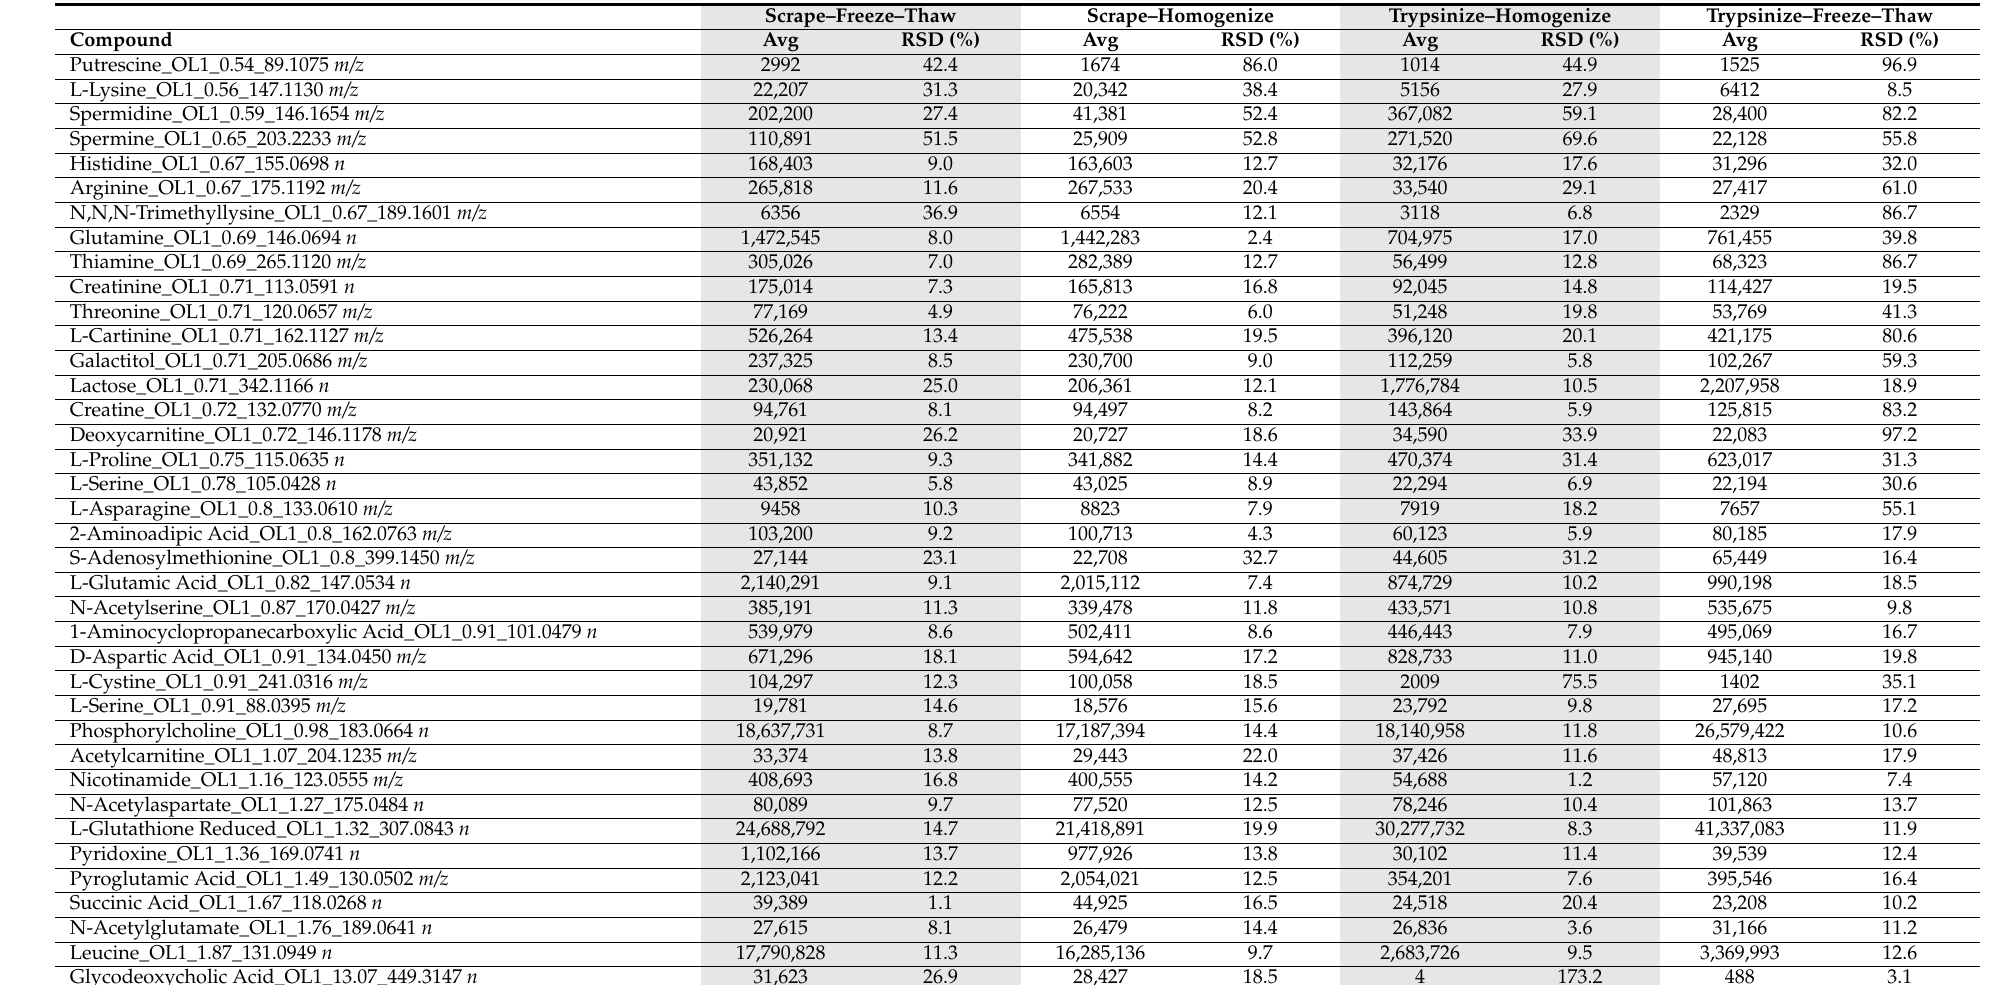
Table 2. Average intensities and relative standard deviations for the identified